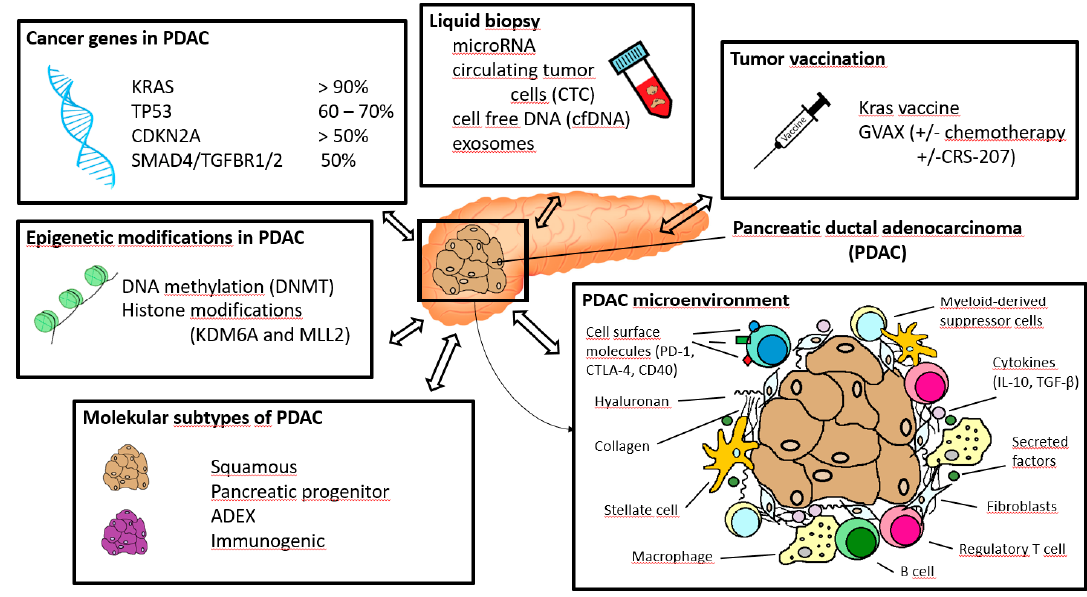
Figure 2. Overview of important aspects in immunotherapy and molecular pathology of pancreatic ductal adenocarcinoma.